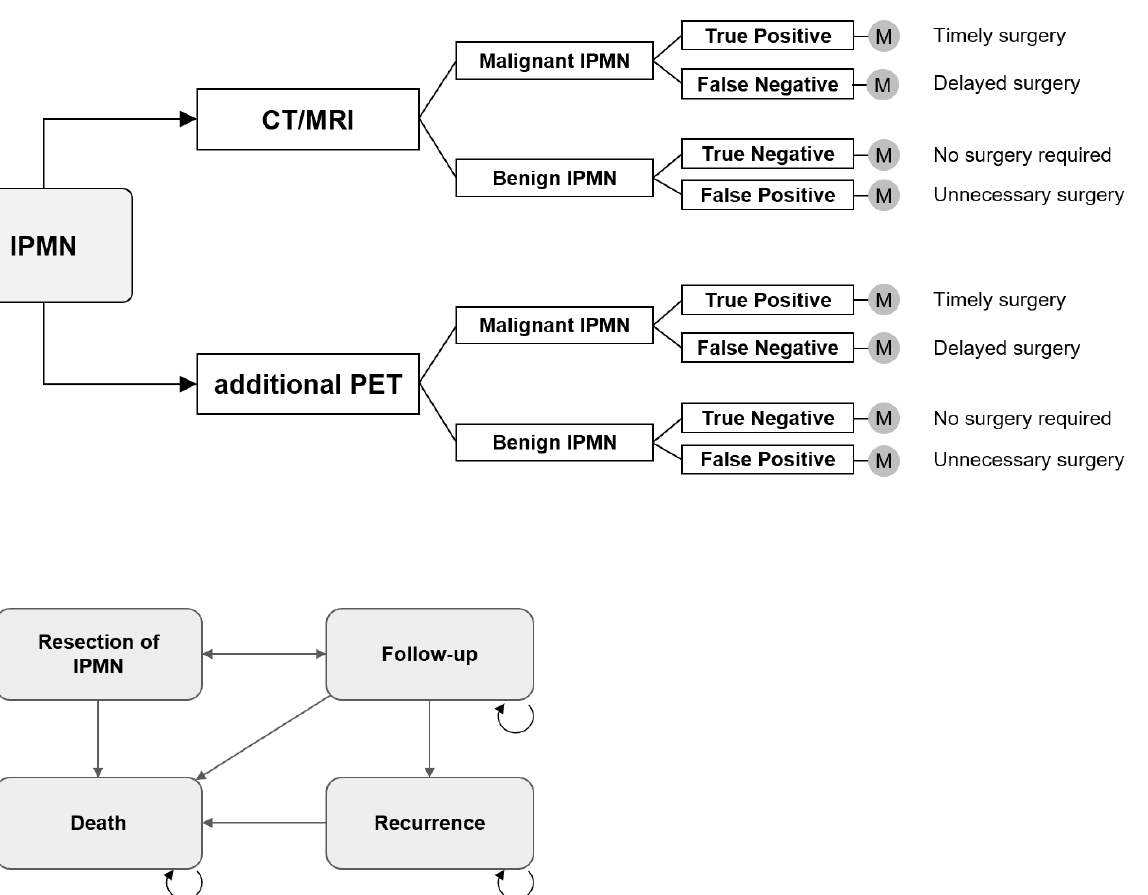
Figure 1. Model structure: ( a ) Decision model for the diagnostic strategies CT/MRI and additional 18 F-FDG-PET/CT. ( b ) Simplified Markov model.2.2 Input parameters.